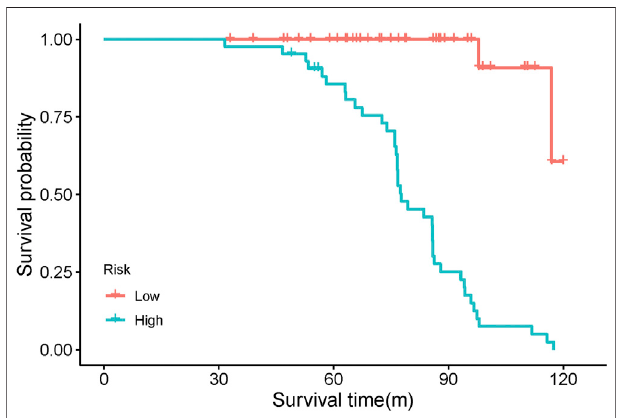
FIGURE 7 | Kaplan-Meier analysis of high-risk and low-risk patients based on risk score.